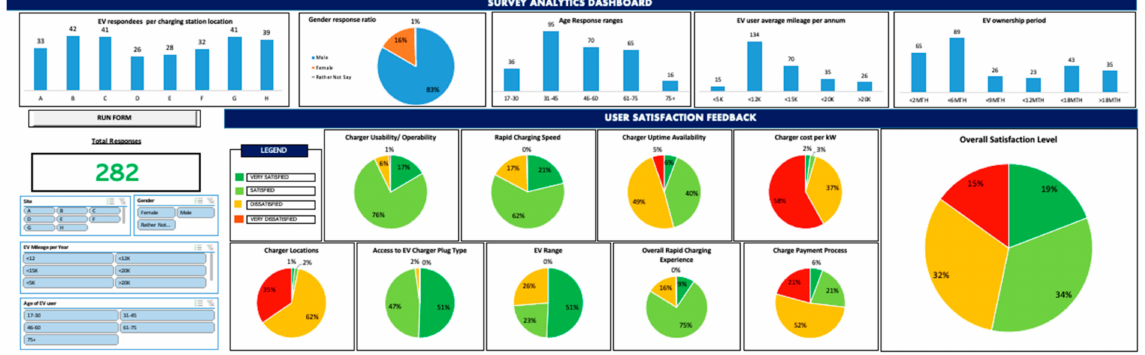
Figure A1. Survey database front end dashboard highlighting all